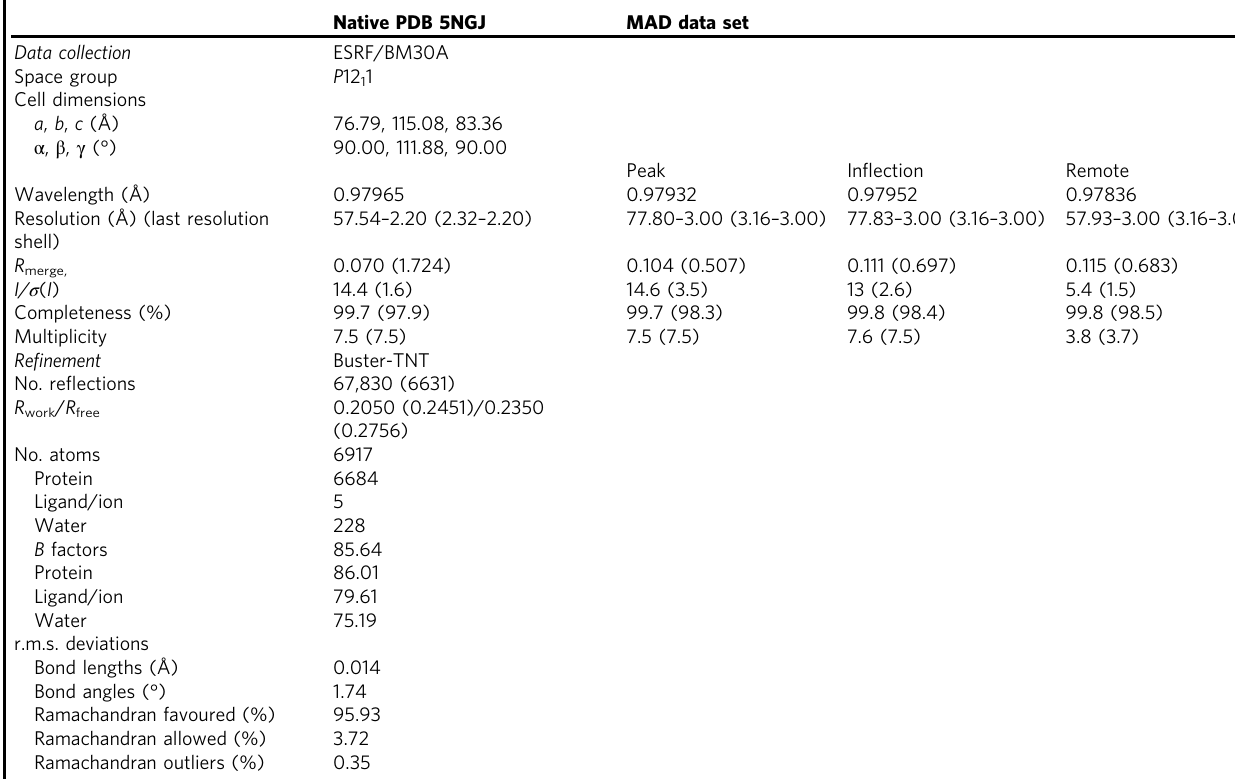
Table 1 Crystallography data collection and re fi nement